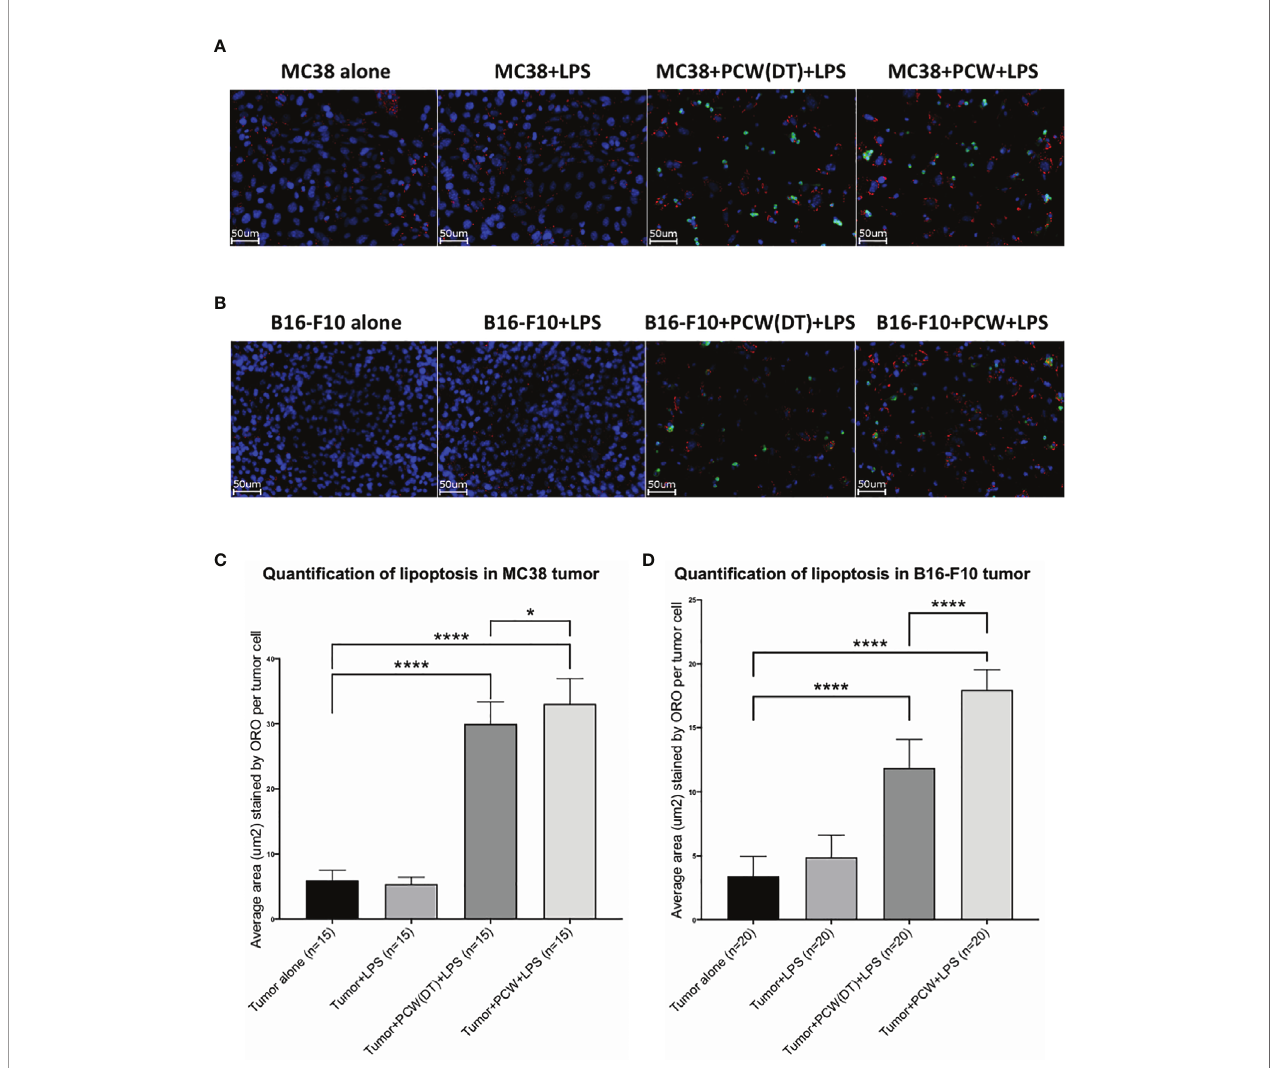
FIGURE 5 | Depletion of L2pB1 cells reduces lipoptosis of both MC38 and B16F10 tumor cells. (A) MC38 colon cancer cells and (B) B16F10 melanoma cells were cultured alone or co-cultured with PCW cells from saline or DT treated mice for 72 hours, in the presence of LPS. Cells were stained with Hoechst 33342 (nuclei), CD45-AF488 (leukocytes) and Oil Red O at 72 hours. Representative images from triplicate wells were taken at 400x magni fi cation. Scale bar (white) = 50 m m. (C, D) Lipoptosis was quanti fi ed as average area of Oil Red O staining per tumor cell ( Supplemental Figure 3 ). MC38 and B16F10 tumor cells treated with L2pB1- depleted PCW cells showed signi fi cant reduction of lipoptosis as compared to wild type PCW cells, ****p < 0.0001 and *p =